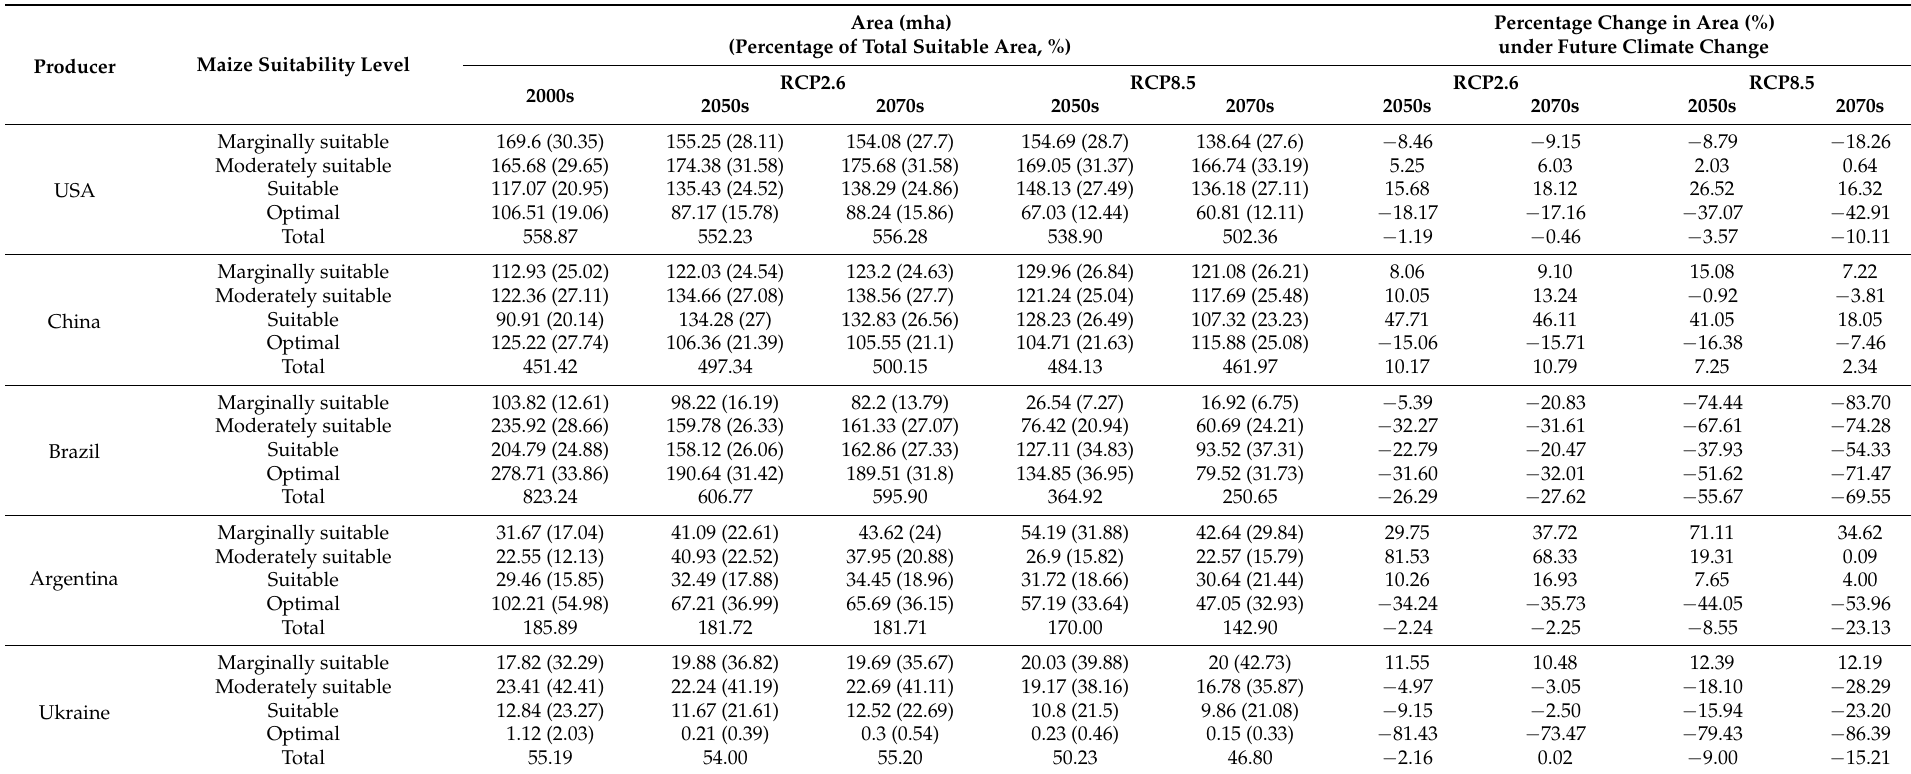
Percentage changes relative to the values during the